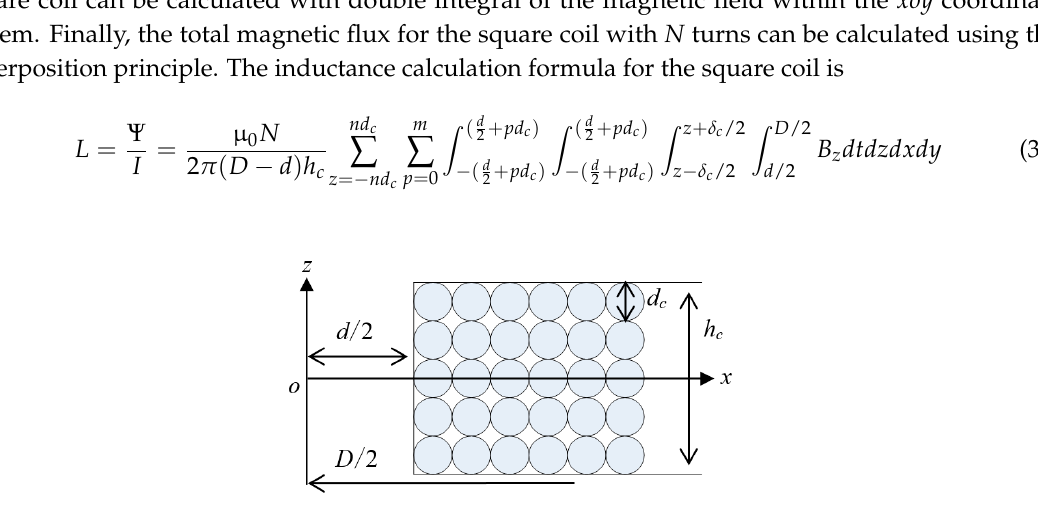
Figure 11. Inductance calculation model for the square coil.